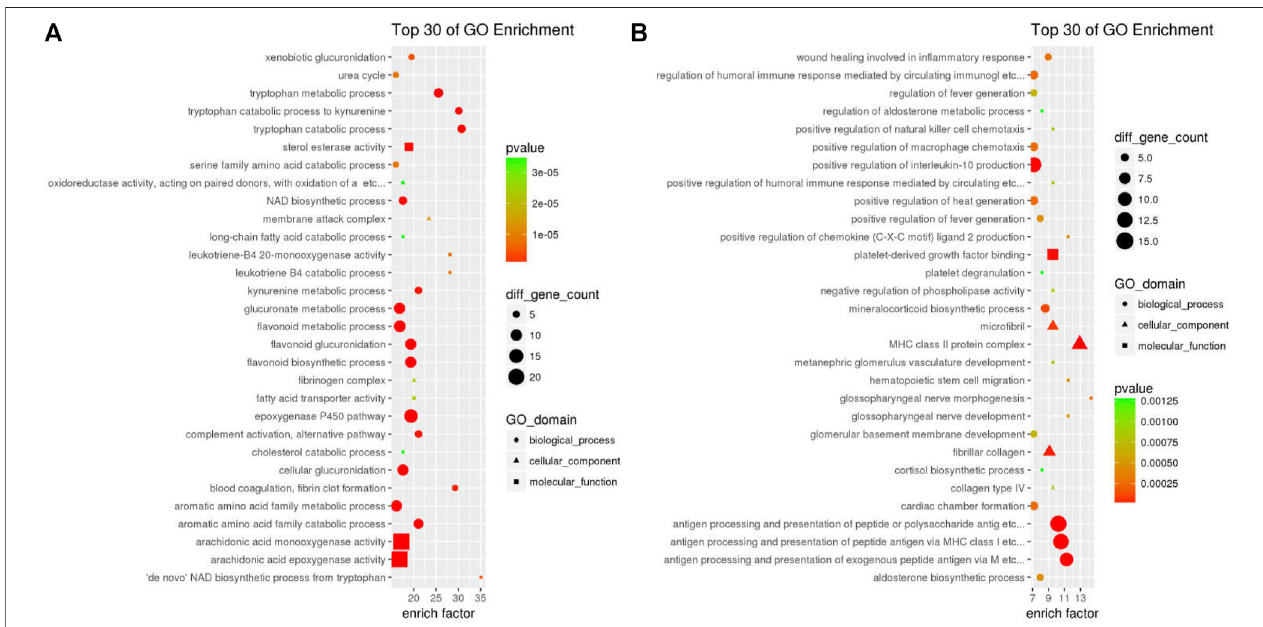
FIGURE 3 | Bubbleplots of the KEGG pathway enrichment analysis results using ClusterPro fi ler for down-DEGs ( (A) and down-DEGs (B) resulting for GDFMD- revised with WD.